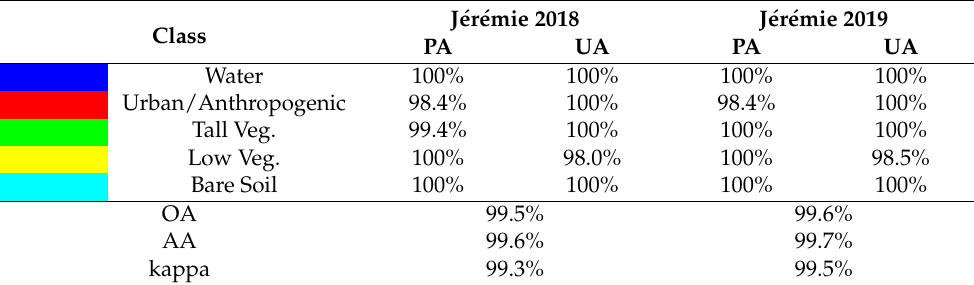
Table 2. Accuracy scores on the test samples for the classification maps corresponding to the datasets “J é r é mie 2018” and “J é r é mie 2019” and obtained with the 2017–2018 and 2018–2019 temporal pairs, respectively. The corresponding maps are shown in Figure 8a,b.